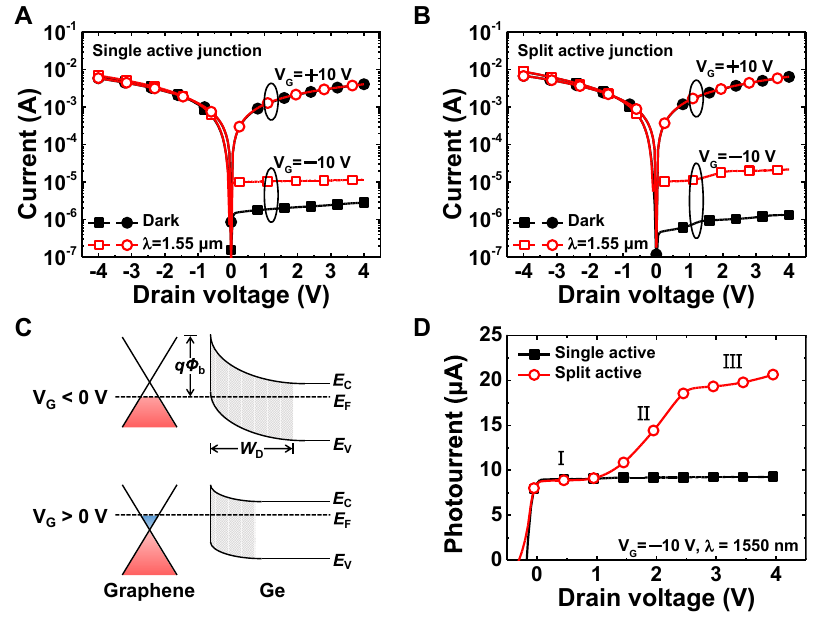
Figure 2: Current – voltage characteristics of the (A) single and (B) split active graphene/ Ge Schottky junction photodetectors in the dark and under illumination. (C)